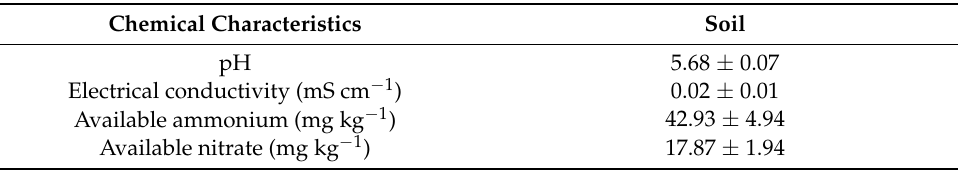
Table 4. Selected soil chemical characteristics before the soil ammonia volatilization experiment.